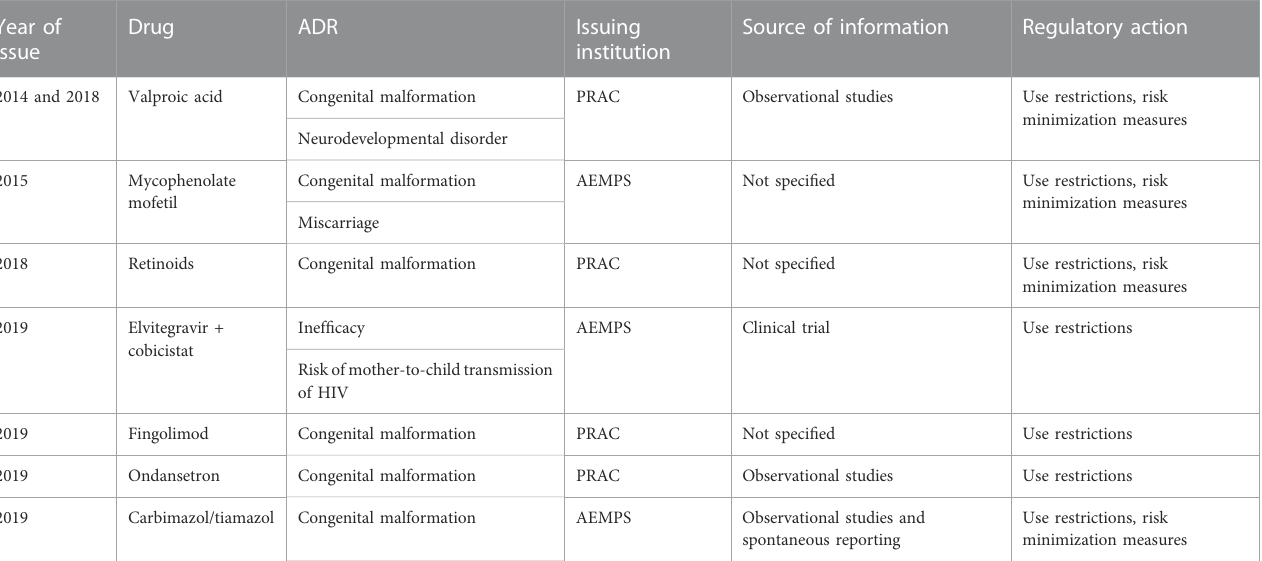
TABLE 7 Characteristics of alerts with drugs addressed to pregnant women.